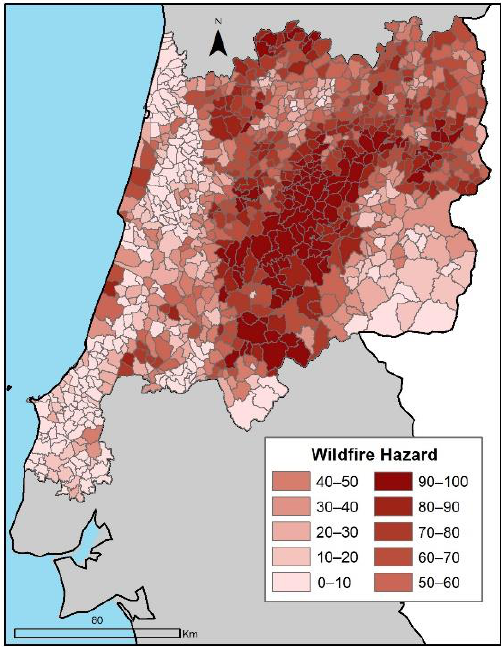
Figure 5. Wildfire hazard, defined for each parish as the percentage of its area classified as having “High” or “Very High” wildfire hazard.